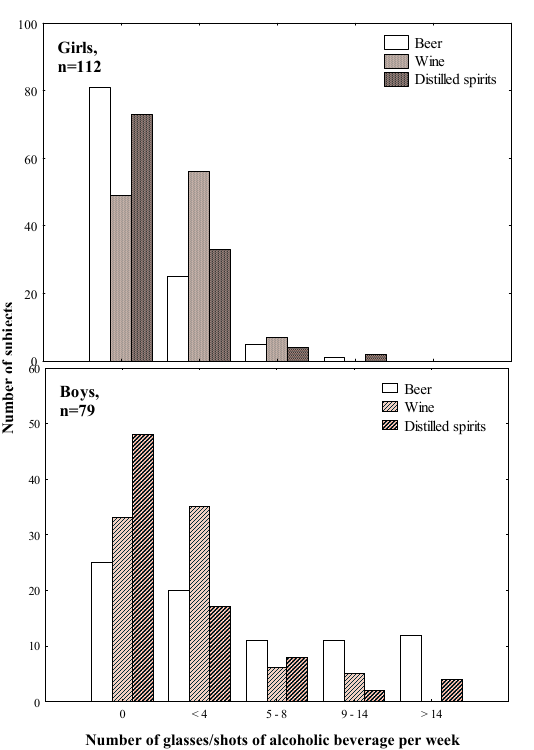
Figure 2. The frequency distributions of the alcohol consumption frequency, stratified according to